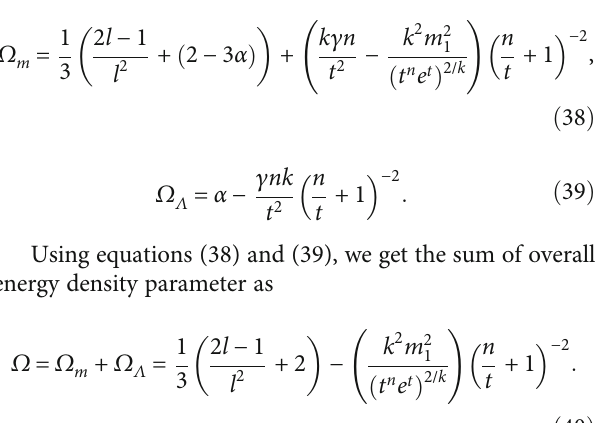
Figure 3 indicates the energy density of dark matter versus cosmic time t for constants l = 1 : 5 , n = 2 , α = 0 : 5 , k = 0 : 5 , m = 0 : 5 , and γ = 0 : 6 . From Figure 3, it can be seen that at 1 early stage of the evolution, energy density dark matter dom- inates and at late times it approaches zero. This supports the recent observations of the cosmological data. Figure 4 indicates the plot of pressure of holographic dark energy versus cosmic time t for constants l = 1 : 5 , n = 2 , k = 0 : 5 , and m = 0 : 5 . As it is shown in Figure 4, the negative 1 pressure of holographic dark energy increases as cosmic time t increases. The negative pressure indicates the accelerated phase of the expansion of the universe. Figure 5 shows the equation of state parameter of dark energy with respect to cosmic time. As it was shown in Figure 5, the dark energy of equation of state lies − 1/3 < w < − 1 which implies the de region of quintessence. Figure 1 shows total density parame- ter versus cosmic time. As it was shown in Figure 1, the total density parameter ð Ω Þ approaches to 1 at late time which exactly matches with the Λ CDM model of recent cosmolog- ical